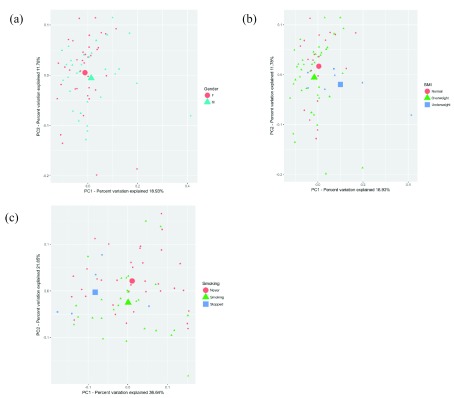
PCoA plots with the larger shapes representing the mean UniFrac distance between samples segregated by (a) gender – unweighted UniFrac; (b) body mass index (BMI) – unweighted UniFrac; (c) smoking status – weighted UniFrac.